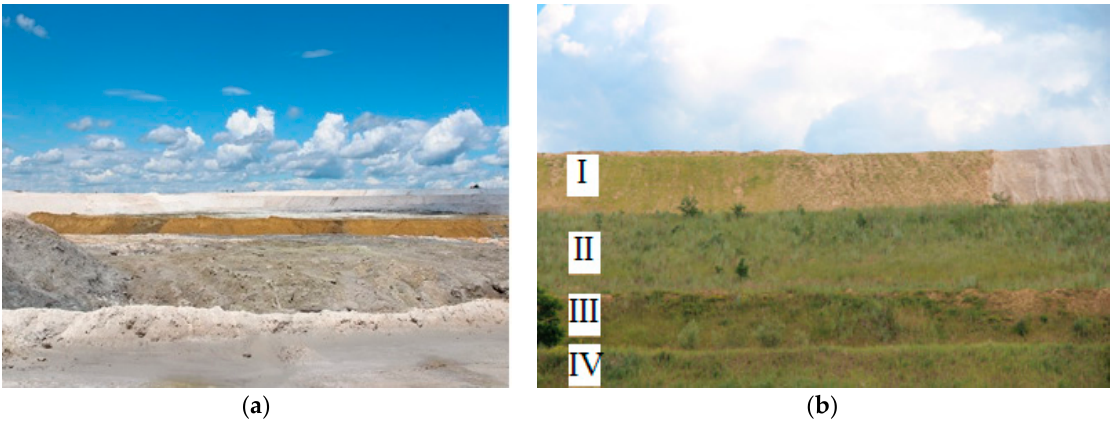
Figure 1. The phosphogypsum dump, Sumy region, Ukraine; ( a ) upper area of the dump massif with “fresh” phosphogypsum, ( b ) terraces (I, II, III, IV) of the phosphogypsum dump.